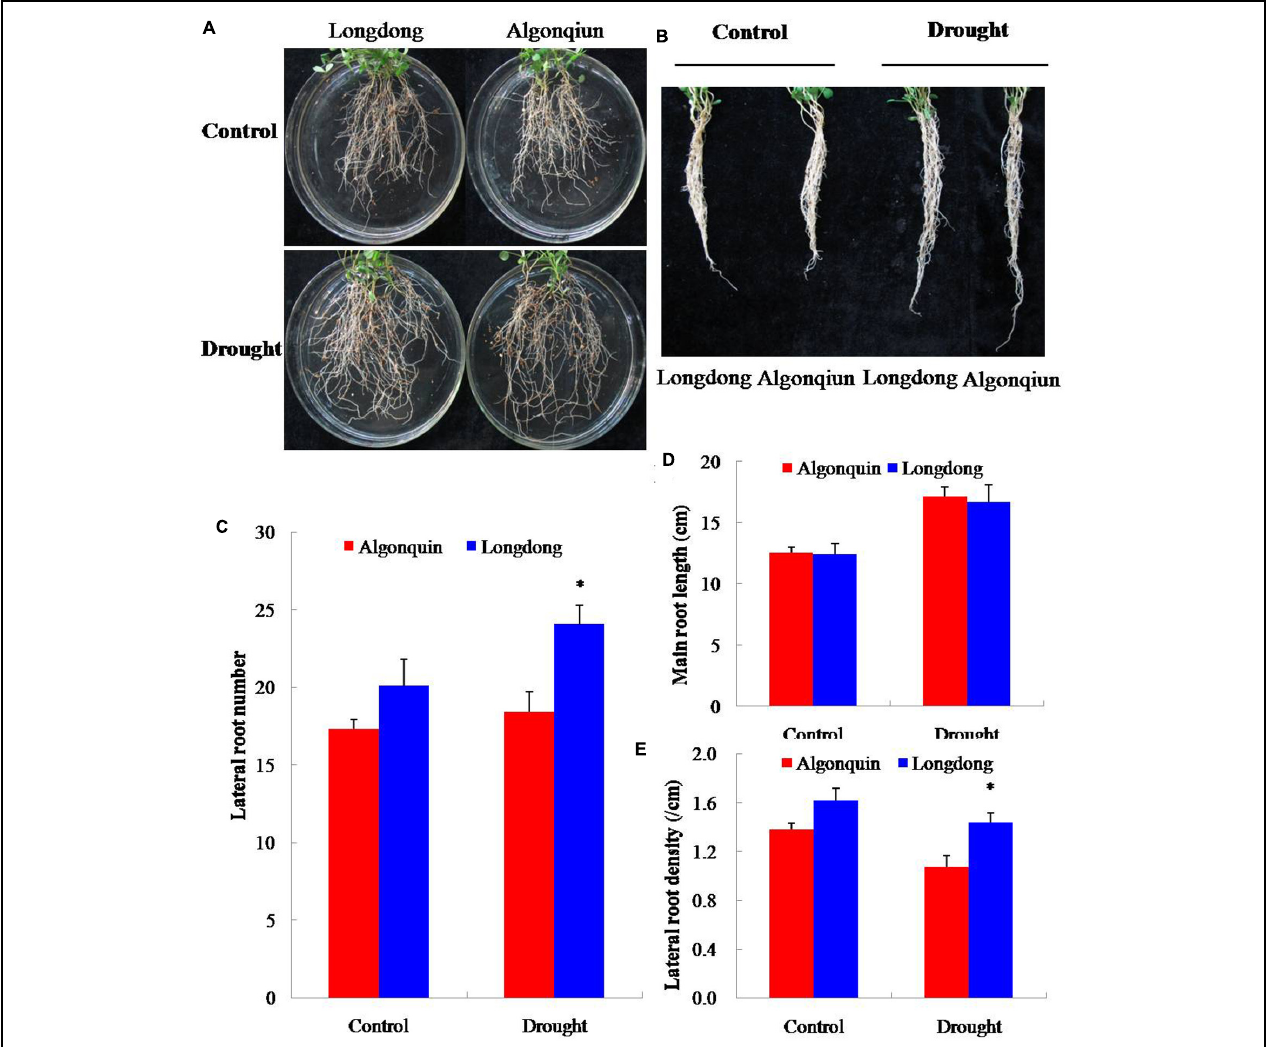
FIGURE 4 | Quantitative analysis of root growth in two alfalfa varieties. (A,B) Roots of Longdong and Algonquin. The root systems of the two varieties were collected from control and stress conditions after drought treatment for 6 days. (C–E) Lateral root number, main root length and lateral root density between two varieties ( n = 15). The results shown are means ± SE. Asterisk symbols indicate significant differences from Algonquin at P < 0.05 (Student’s t